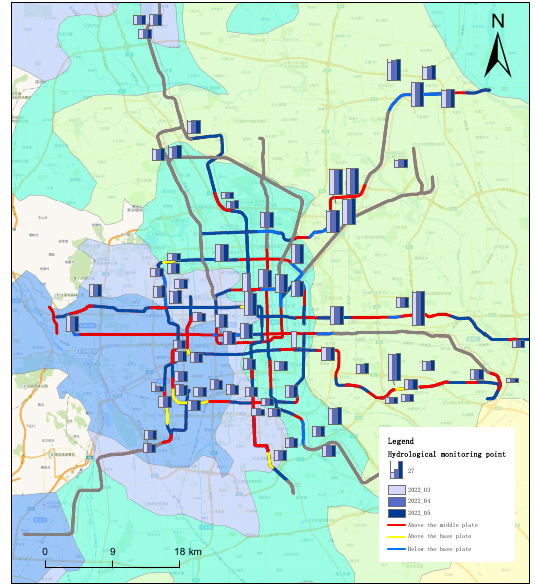
Figure 3. Distribution map of monitoring points Groundwater leakage is a complex and comprehensive problem. The system platform realizes the retrieval, attribute query and display, and positioning of groundwater data. The system platform realizes dual-screen comparison, provides historical data comparison and analysis functions, and realizes automatic identification of groundwater changes through data